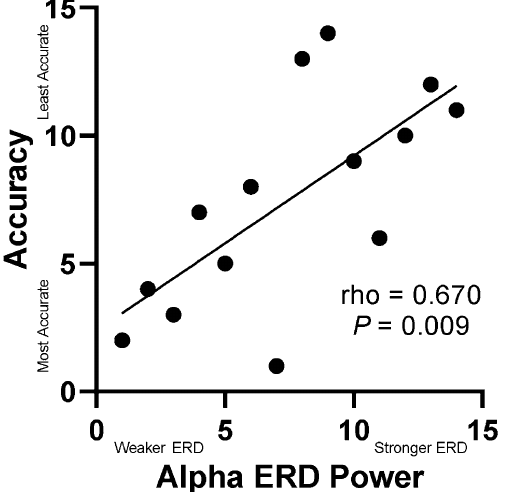
Figure 4. Rank-order correlation analysis between accuracy and alpha ERD Power. The alpha ERD peak voxel was identified in the left insula interaction effect map for the incongruent condition in the CP group only. Rank-order of the alpha ERD is shown on the x-axis, while the rank-order of accuracy is shown on the y-axis. As shown, there was a significant postive correlation between the strength of the change in the alpha ERD and the participant’s accuracy (rho = 0.670; P = 0.009). This correlation implies that adolescents with CP that had stronger alpha oscillations in the left insula also tended to make more errors in their perception of the target arrow’s direction. ERD event-related